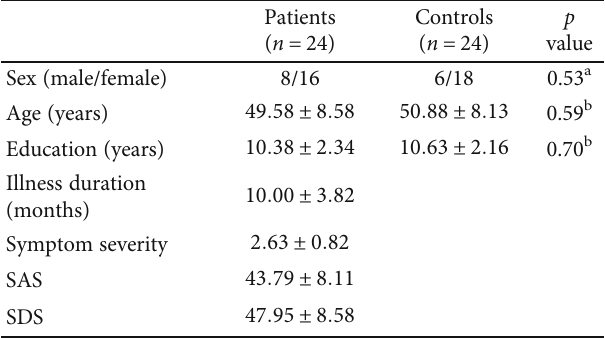
Table 1: Characteristics of the